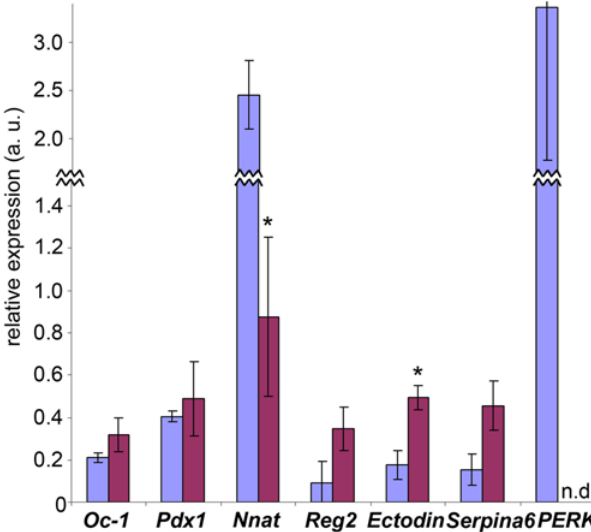
Figure 3. RT-PCR validation of microarray results. P1 pancreatic WT (blue) and Hnf6 Tg (purple) RNA was analyzed for the expression of the transcripts indicated. Values are expressed in arbitrary units as a ratio (transcript:tubulin) of the average of individual samples for each genotype. Error bars represent SEM; * p , 0.05. n.d. , not detectable. For comparison, microarray analysis of these same transcripts revealed the following: OC-1 increased two-fold; Pdx1 no change; Nnat decreased two-fold; Reg2 increased 1.7-fold; Ectodin increased 1.6- to 1.9-fold; Serpina6 increased 4.6-fold; PERK decreased two-fold.